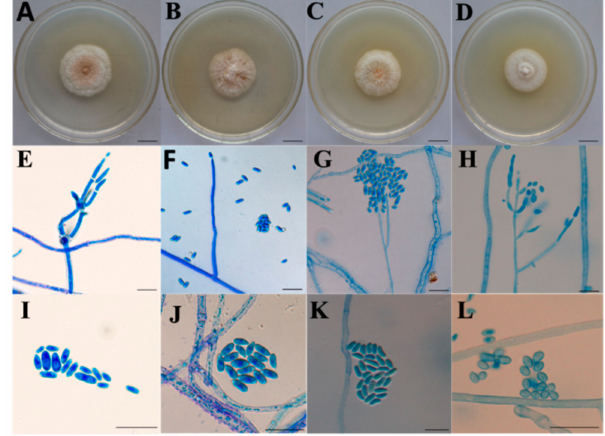
Figure 1. Culture and micromorphological characteristics with asexual morphs of four Clonostachys species in this study. ( A – D ): Culture of C. compactiuscula , C. rogersoniana , C. solani and Clonostachys sp.;